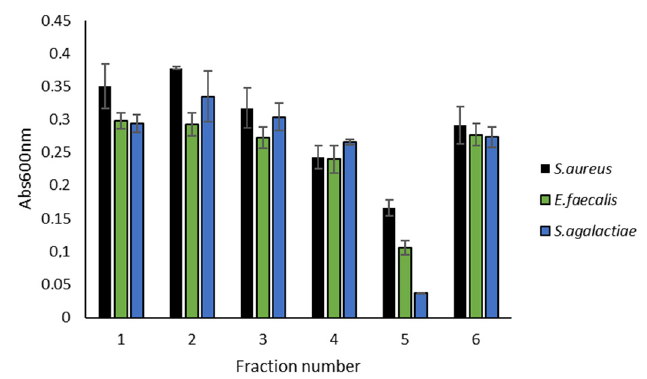
Figure 2. Antibacterial effect of flash fractions 1–6 from M09B143 extract against Gram-positive bac-